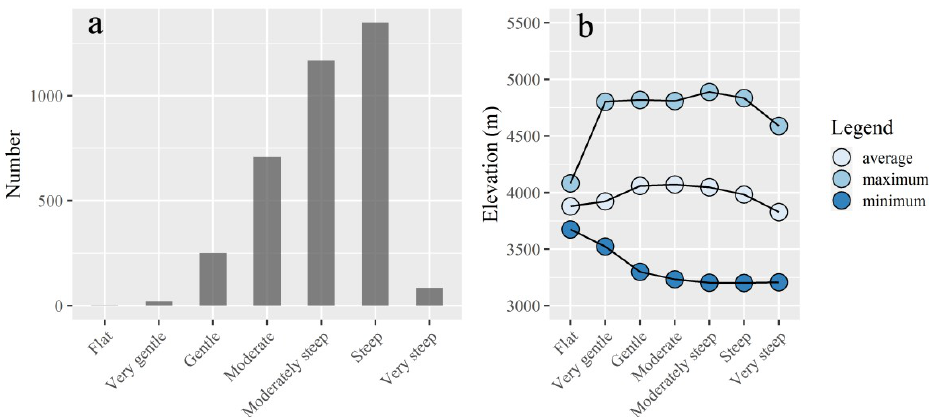
Figure 7. Distribution of nearest alpine timberline points on different slope classifications: ( a ) number of nearest alpine timberline points; ( b ) average, maximum, and minimum elevations of nearest alpine timberline points.